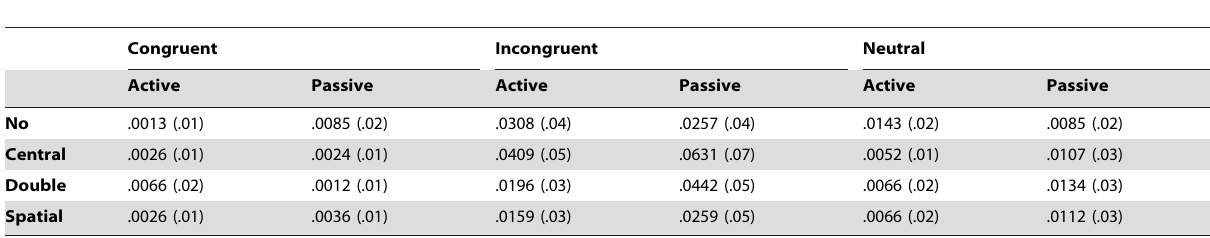
Table 3. Mean proportions of errors and standard deviations in the different Flanker and Cue conditions.